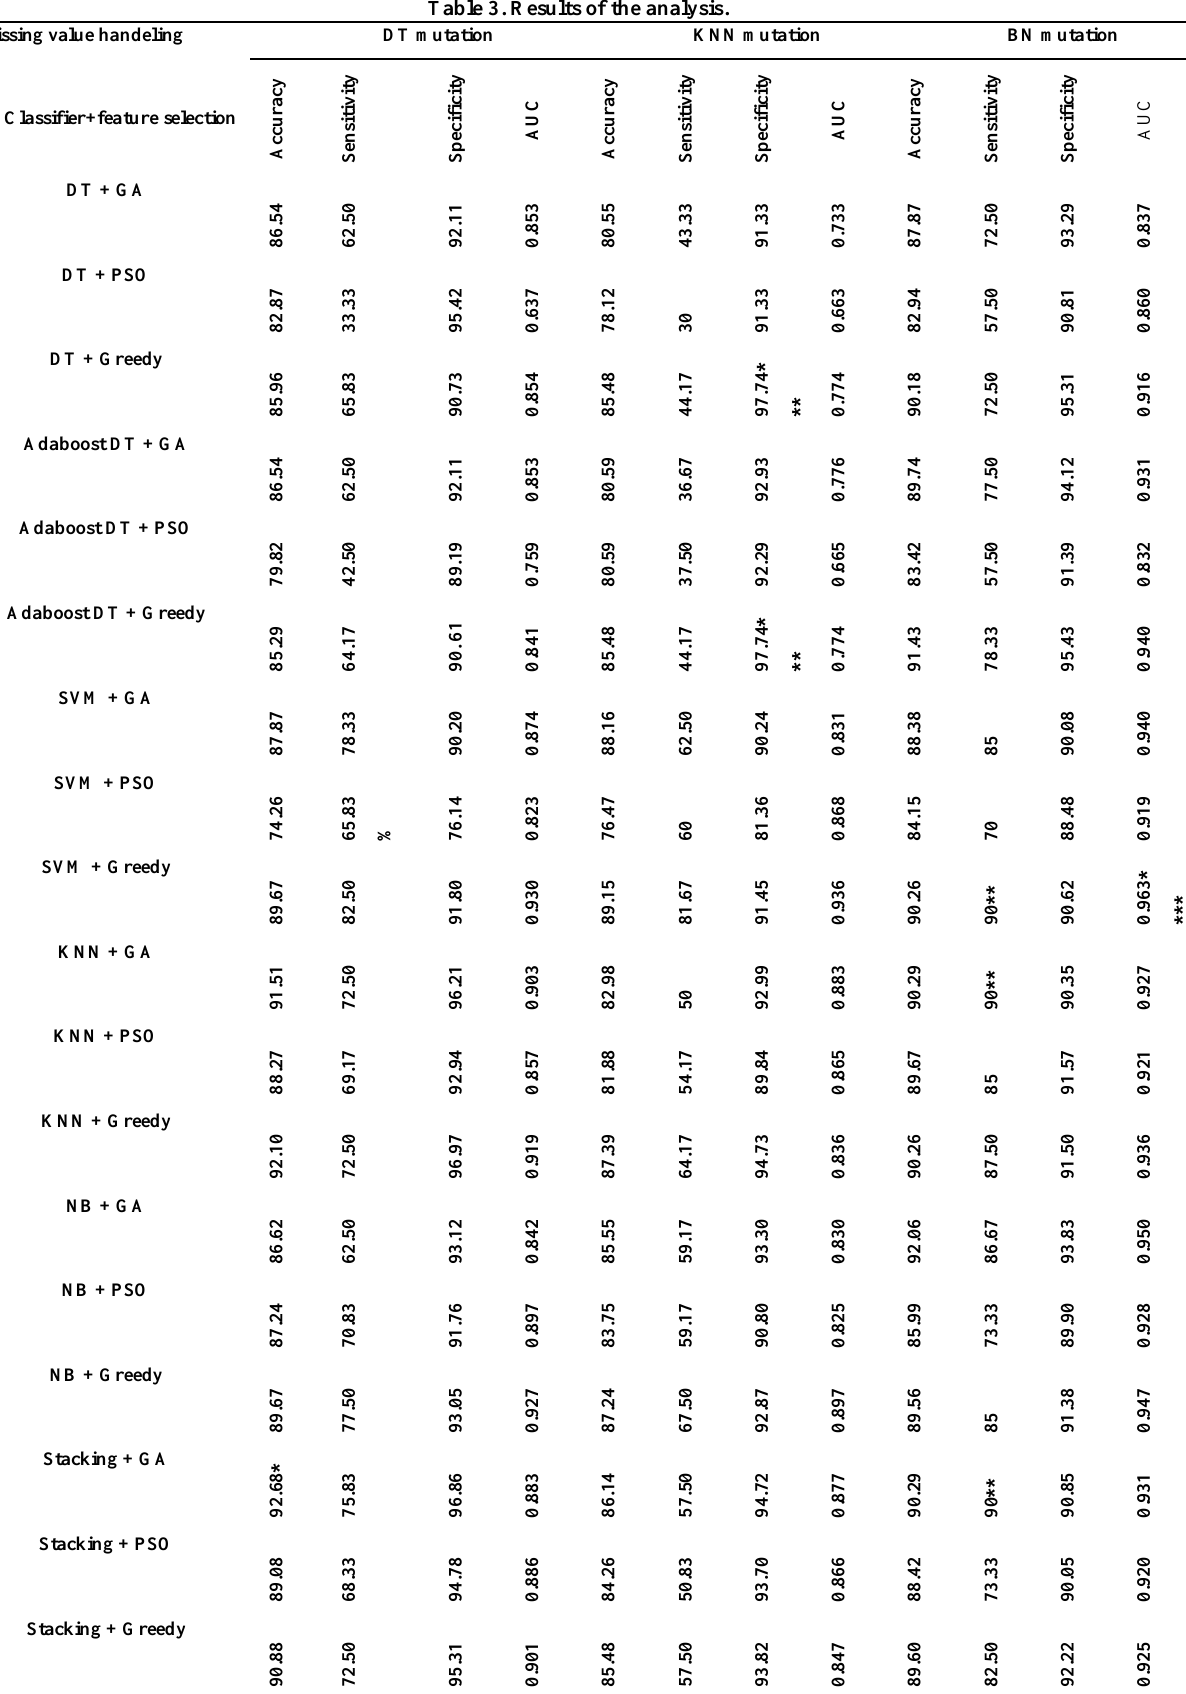
Table 3. Results of the